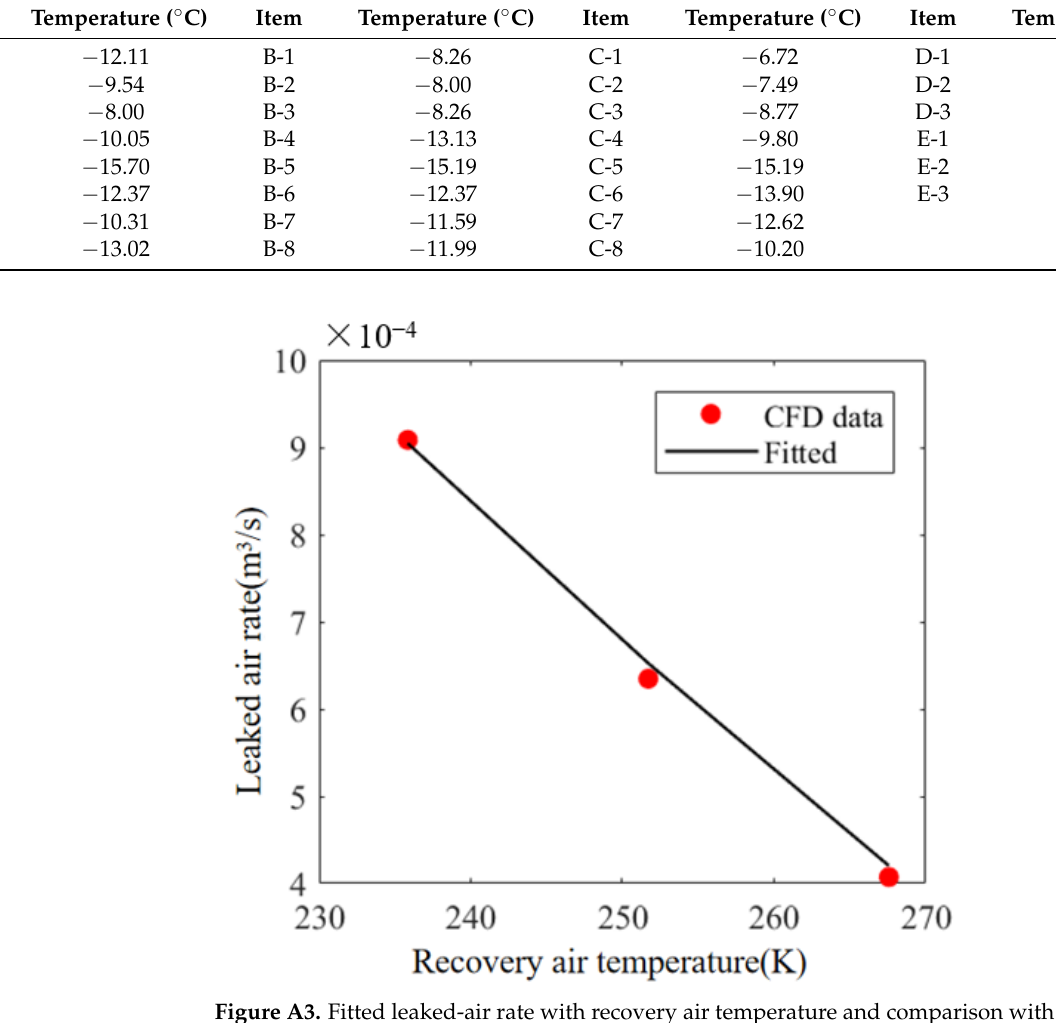
Figure A3. Fitted leaked-air rate with recovery air temperature and comparison with CFD data.